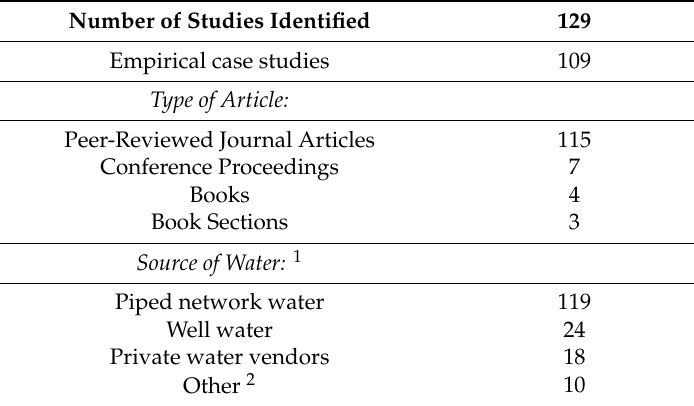
Table 1. Summary of Literature Search on Intermittent Water Supply.